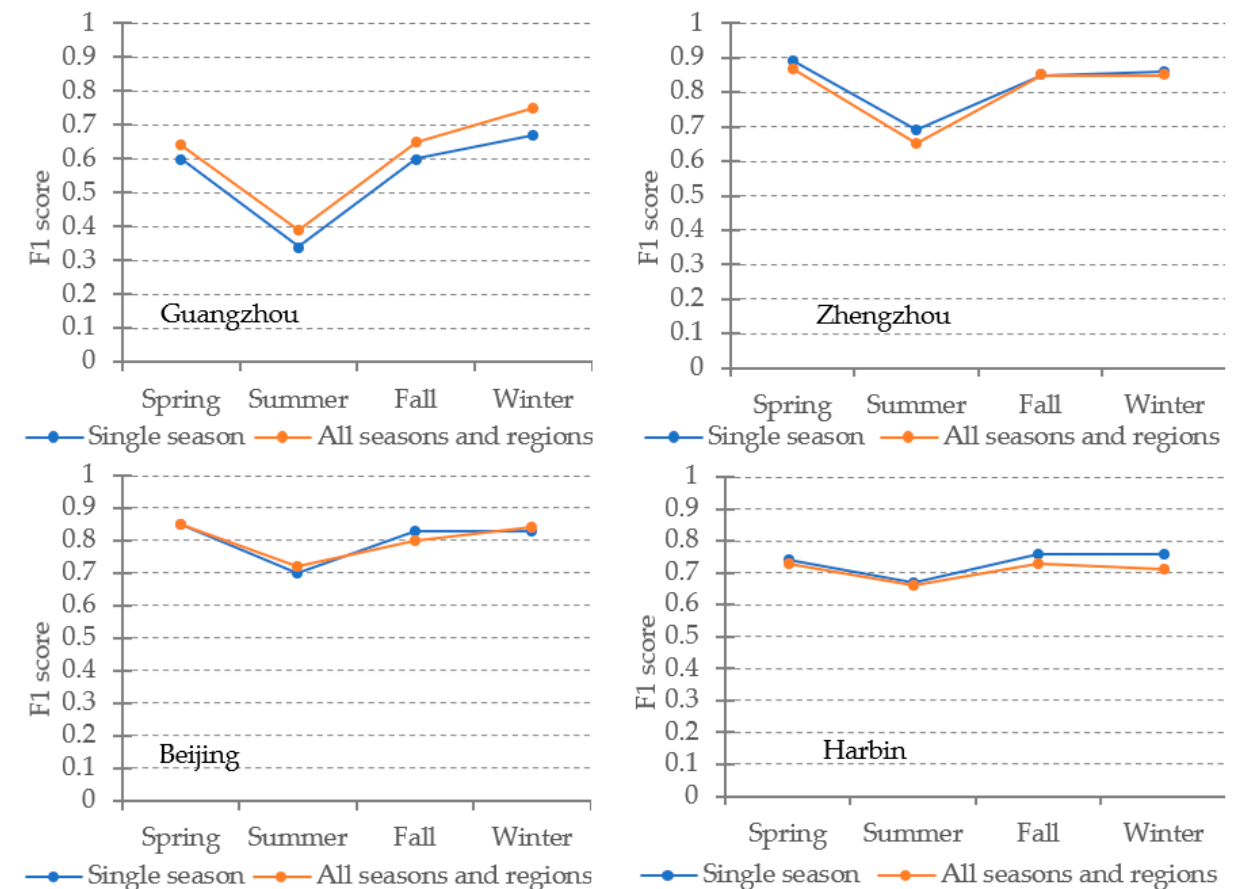
Figure 9. F1 scores of FCN models validated on different combinations of region and season. All seasons and regions model in yellow line is trained on the seasonally and regionally combined samples.